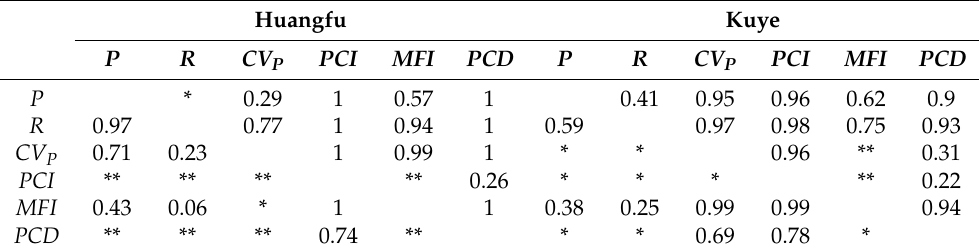
Table 4. Correlation coefficient test between rainfall indexes and sediment